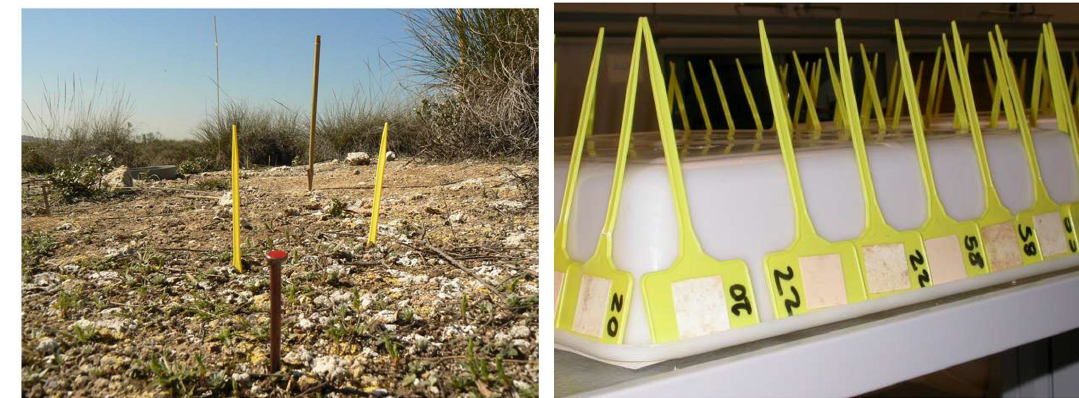
Figure 17. View of ion exchange membranes placed in the field on the left and after field collection on the right. Photographs by An- drea P.